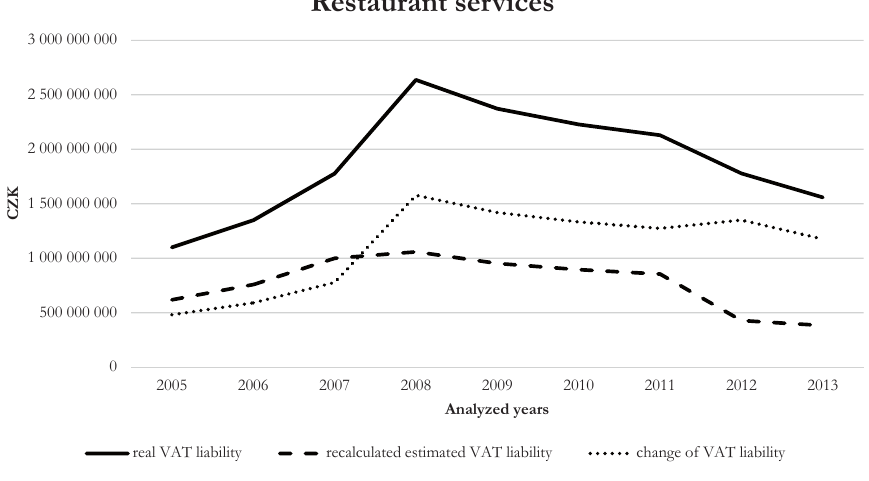
Fig. 1 - Real and recalculated estimated VAT liability of restaurant services. Source: Authors´ calculation accord- ing to the questionnaire research and